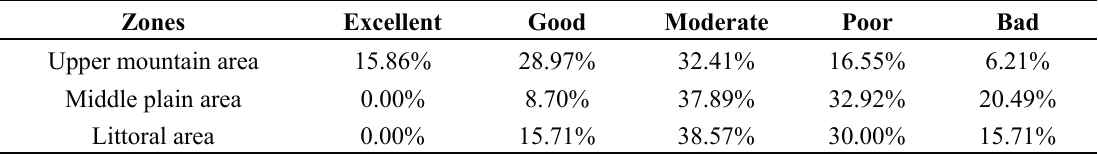
Table 2. Proportion of sampling sites in the different RHQ classes in the three zones.